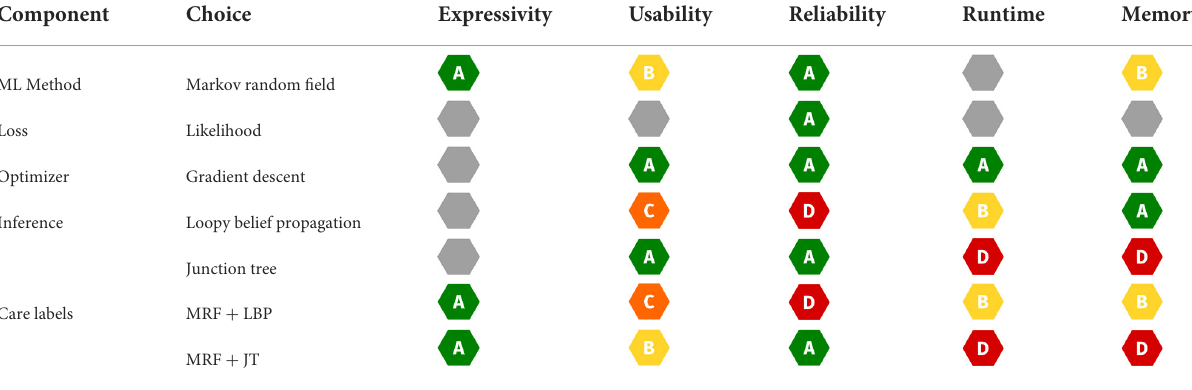
TABLE 4 Guarantees and resource consumption of different inference algorithms.